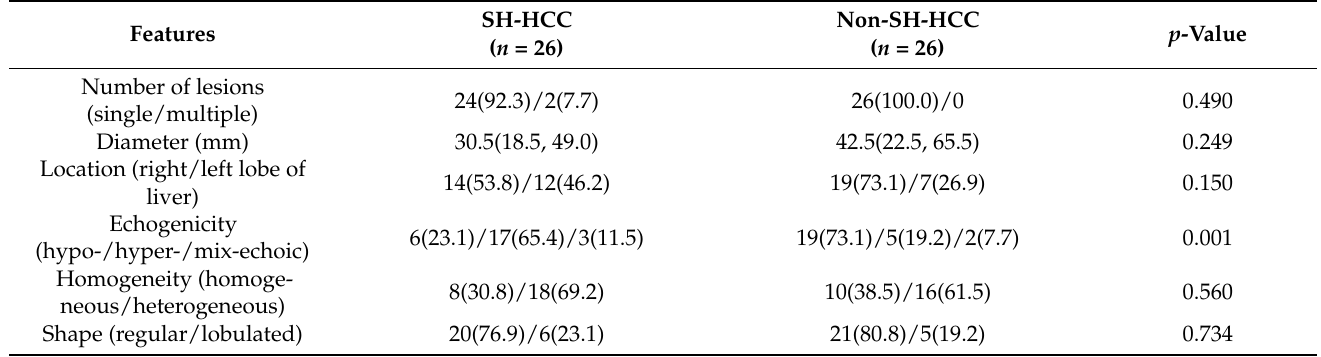
Table 2. Imaging features of the SH-HCCs and non-SH-HCCs as seen via BMUS and CEUS